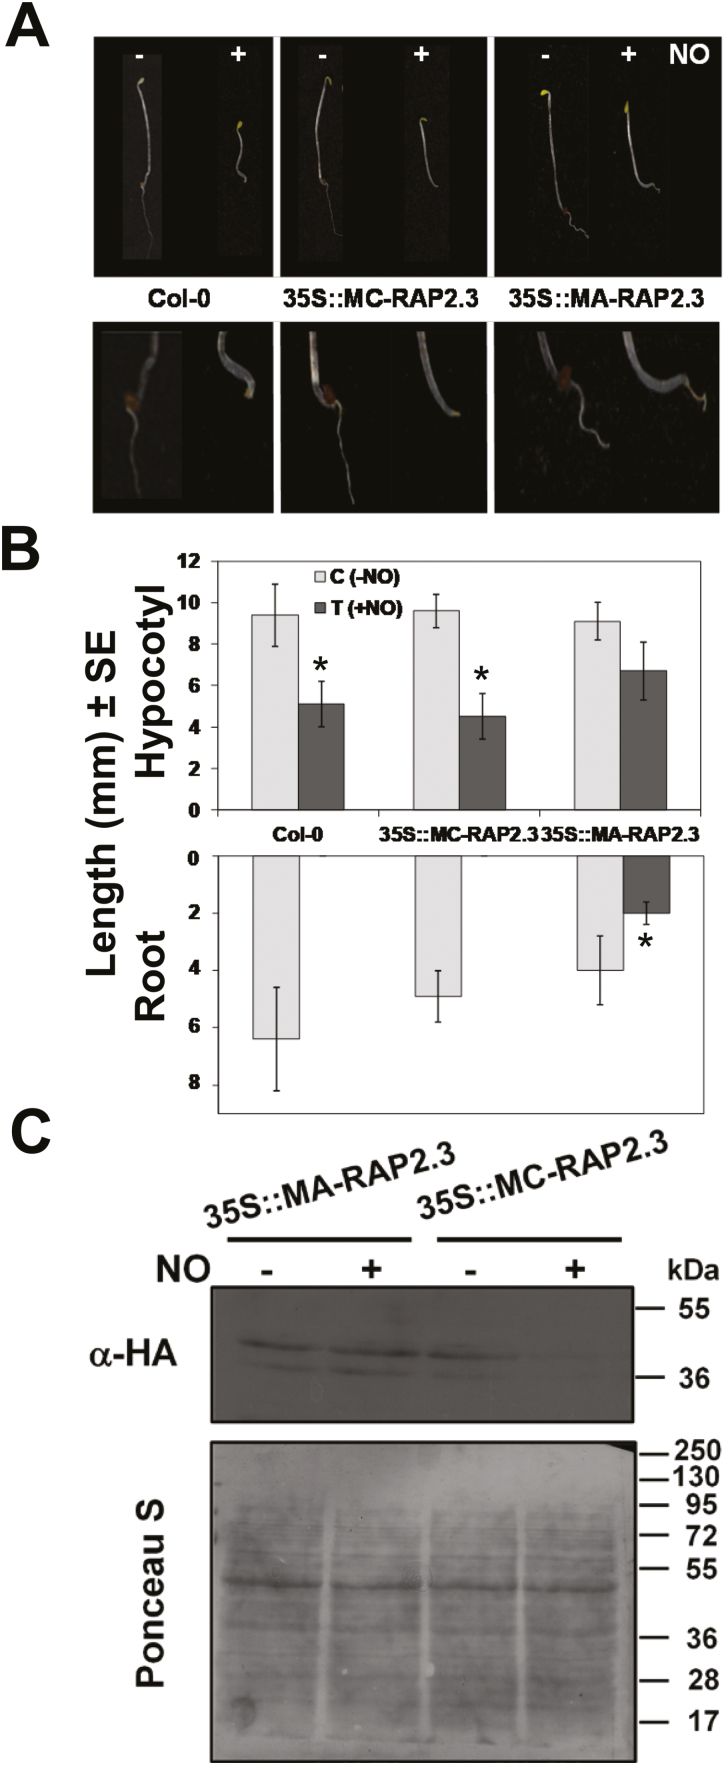
Overexpression of non-degradable MA-RAP2.3 confers hyposensitivity to NO in Arabidopsis. (A) Hypocotyls (upper panels) and roots (lower panels) of etiolated seedlings either with (+) or without (–) NO treatment (300 ppm) for transgenic plants overexpressing either MA-RAP2.3 or the degradable form MC-RAP2.3, compared with the wild-type Col-0. (B) Lengths of hypocotyls and primary roots of the transgenic plants compared with Col-0. ImageJ was used to measure the lengths for at least 20 seedlings. Significant differences between control (C, –NO) and treated (T, +NO) plants were determined using Student’s t-test: *P<0.05. (C) Levels of RAP2-3-HA in protein extracts from etiolated seedlings with NO (+) or without (–) NO treatment, as determined by western blotting with anti-HA antibodies. Total protein staining with Ponceau S is shown as the loading control. The position of molecular weight markers is shown at the right.